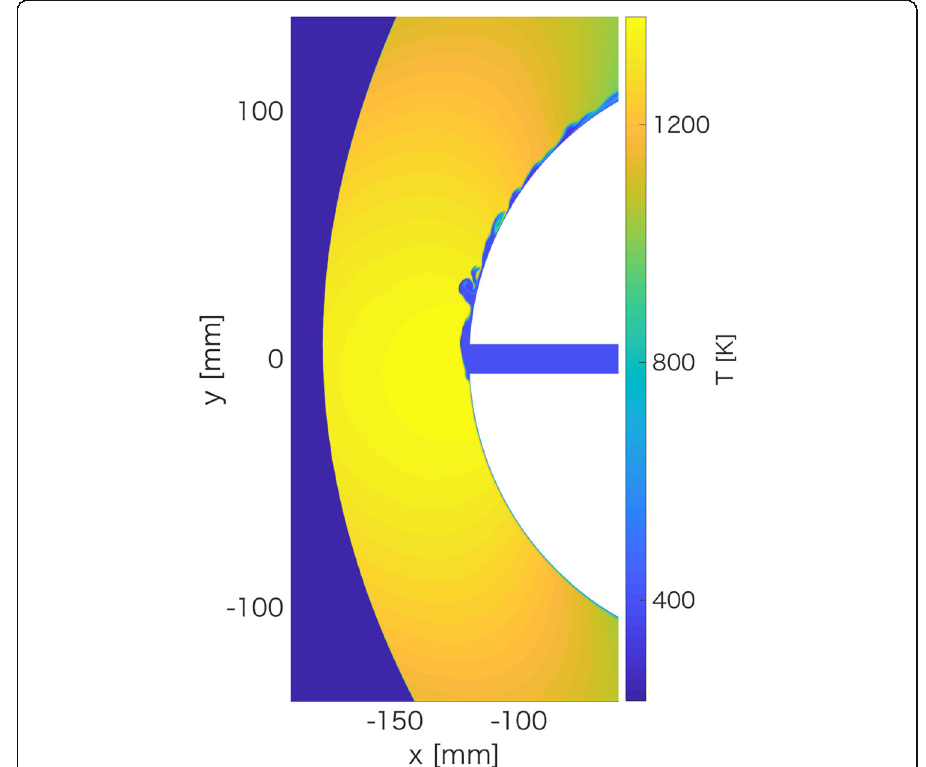
Fig. 6 A snapshot of the temperature field (Case-A, Model-1, Ω = 3°, 8.8 × 10 5